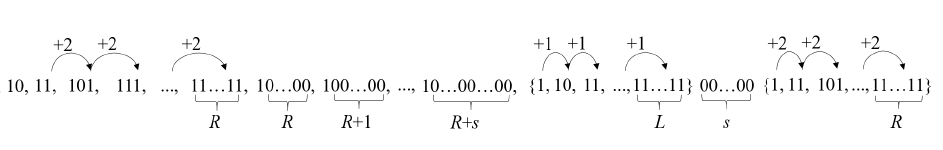
Fig. 5. The lengths in step (1),(2) and (3) are 2 R − 1 + 1 , s + 1 and (2 L − 1)2 R − 1 . The total length is 2 k − 1 + s + 2.